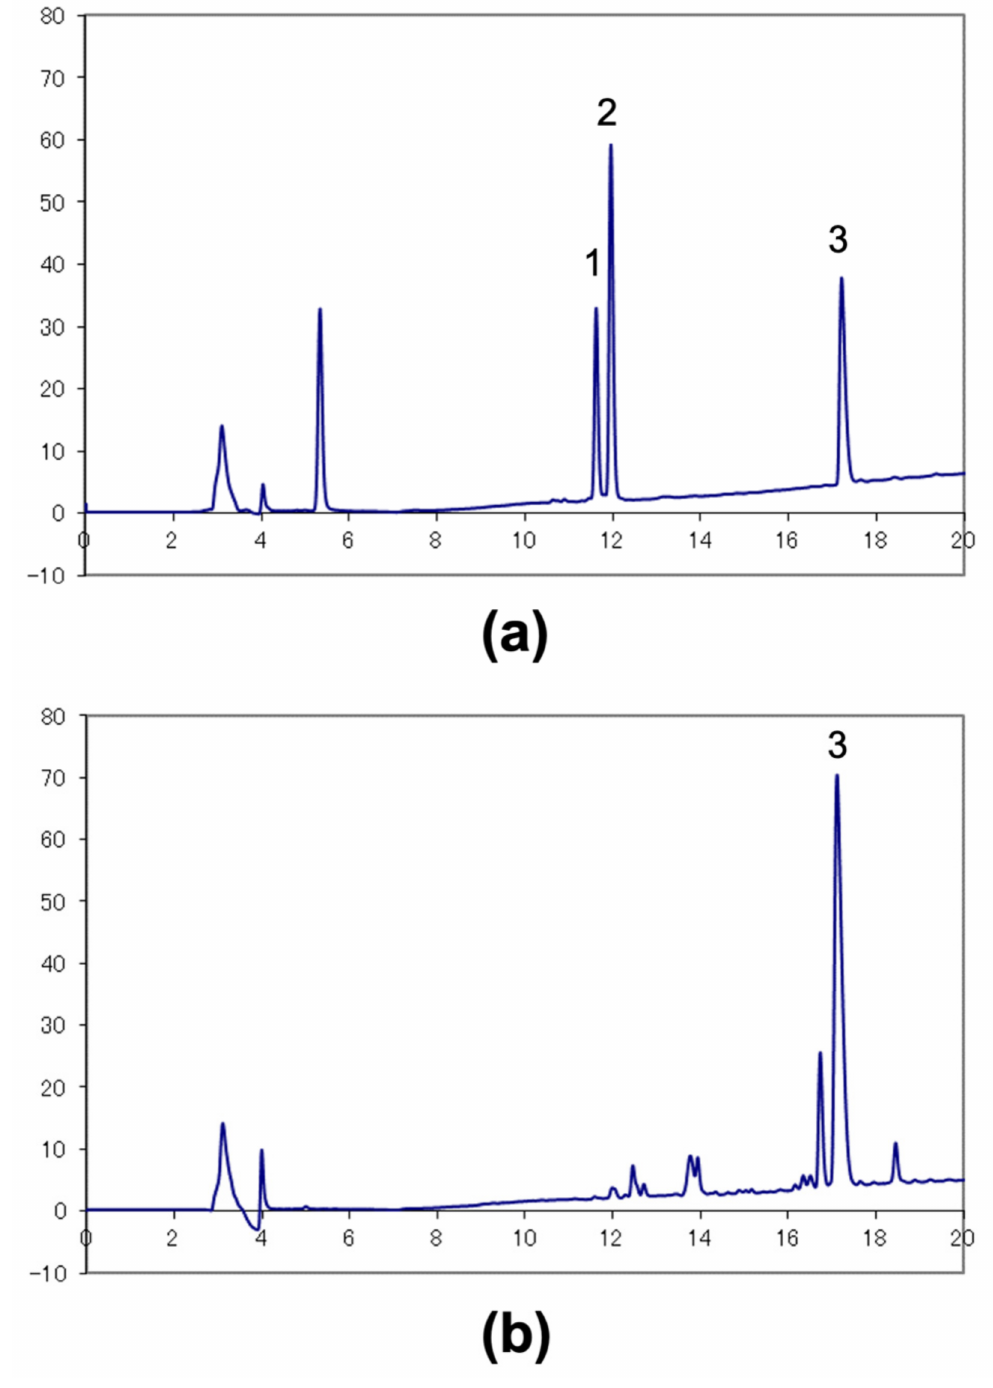
Figure 1. High-performance liquid chromatography (HPLC) chromatograms of α -tomatine and tomatidine standards ( a ) and the tomatidine-rich tomato leaf extract (TRTLE) ( b ). Peaks from (1) dehydrotomatine, (2) α -tomatine, and (3)